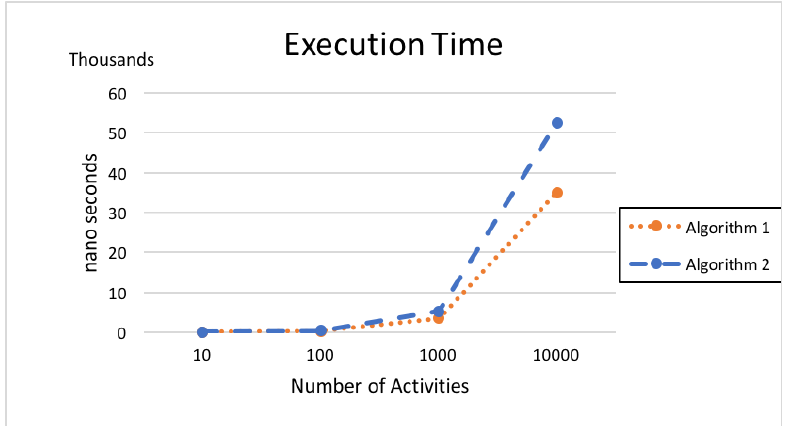
Figure 14. Execution Time of Algorithm 1 and Algorithm